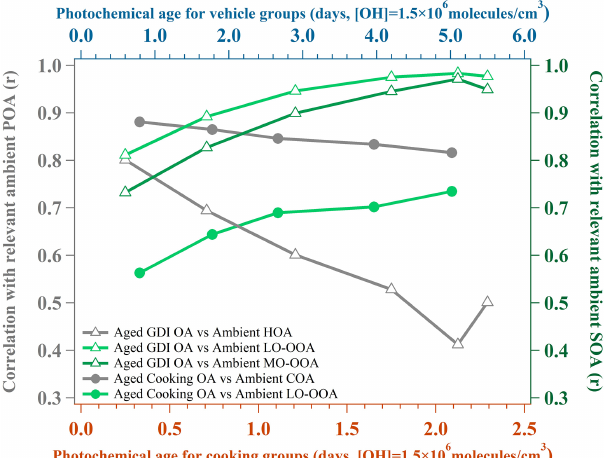
Figure 7. Correlation coefficients (Pearson r ) between the aged lab- oratory OA and published ambient PMF OA factors with growing photochemical ages. Ambient PMF OA factors are the average re- sults from two field studies in Beijing (measured at a typical ur- ban site during autumn and winter; autumn, 1 October–15 Novem- ber 2018; winter, 5–31 January 2019). The unit mass resolution mass spectra are determined by an